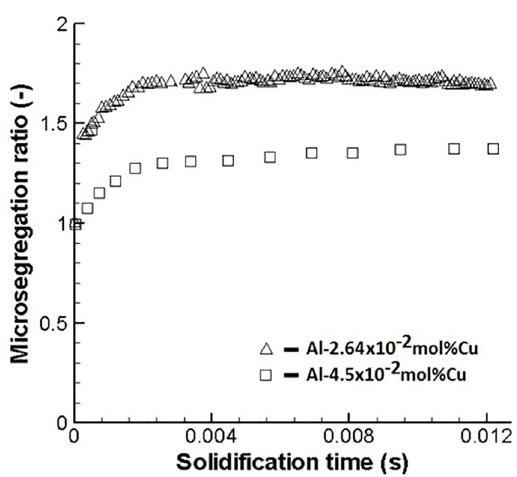
Figure 7: The microsegregation ratio (C time ( t